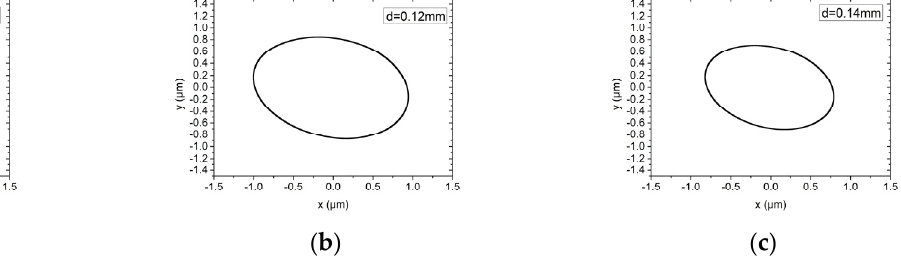
Figure 14. Rotor center trajectory under different orifice diameter under working condition 6 (high speed, dynamic unbalance G0.1). ( a ) Rotor center trajectory ( d = 0.10 mm), ( b ) rotor center trajectory ( d = 0.12 mm), ( c ) rotor center trajectory ( d = 0.14 mm).